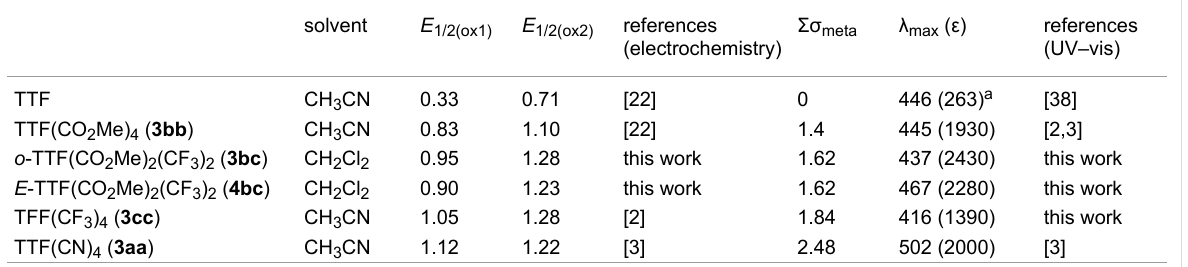
Table 2: Electrochemical and spectroscopic data of tetrasubstituted TTF derivatives. E 1/2 values are reported in V vs SCE reference electrode. Lowest energy absorption maximum λ max (nm) and molar extinction coefficient ε (L·mol − 1 ·cm − 1 ) are determined in CH 2 Cl 2 unless otherwise specified).